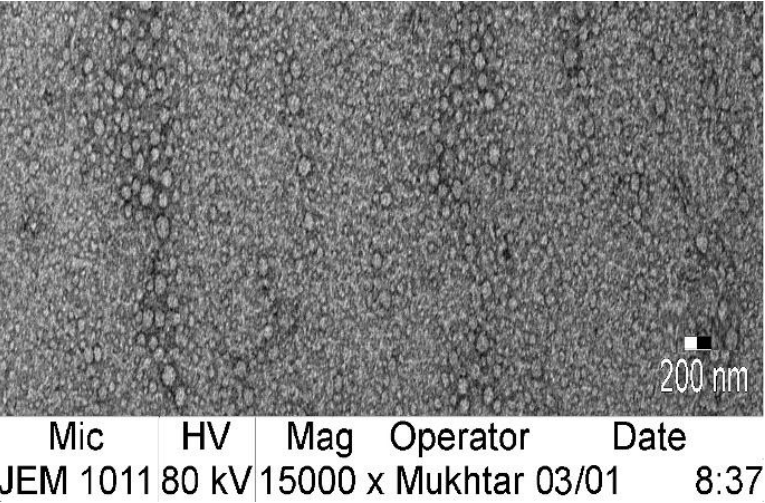
Figure 8. SEM for the optimized nanoemulgel loaded with the optimized LV-Eu-SNEDDS.